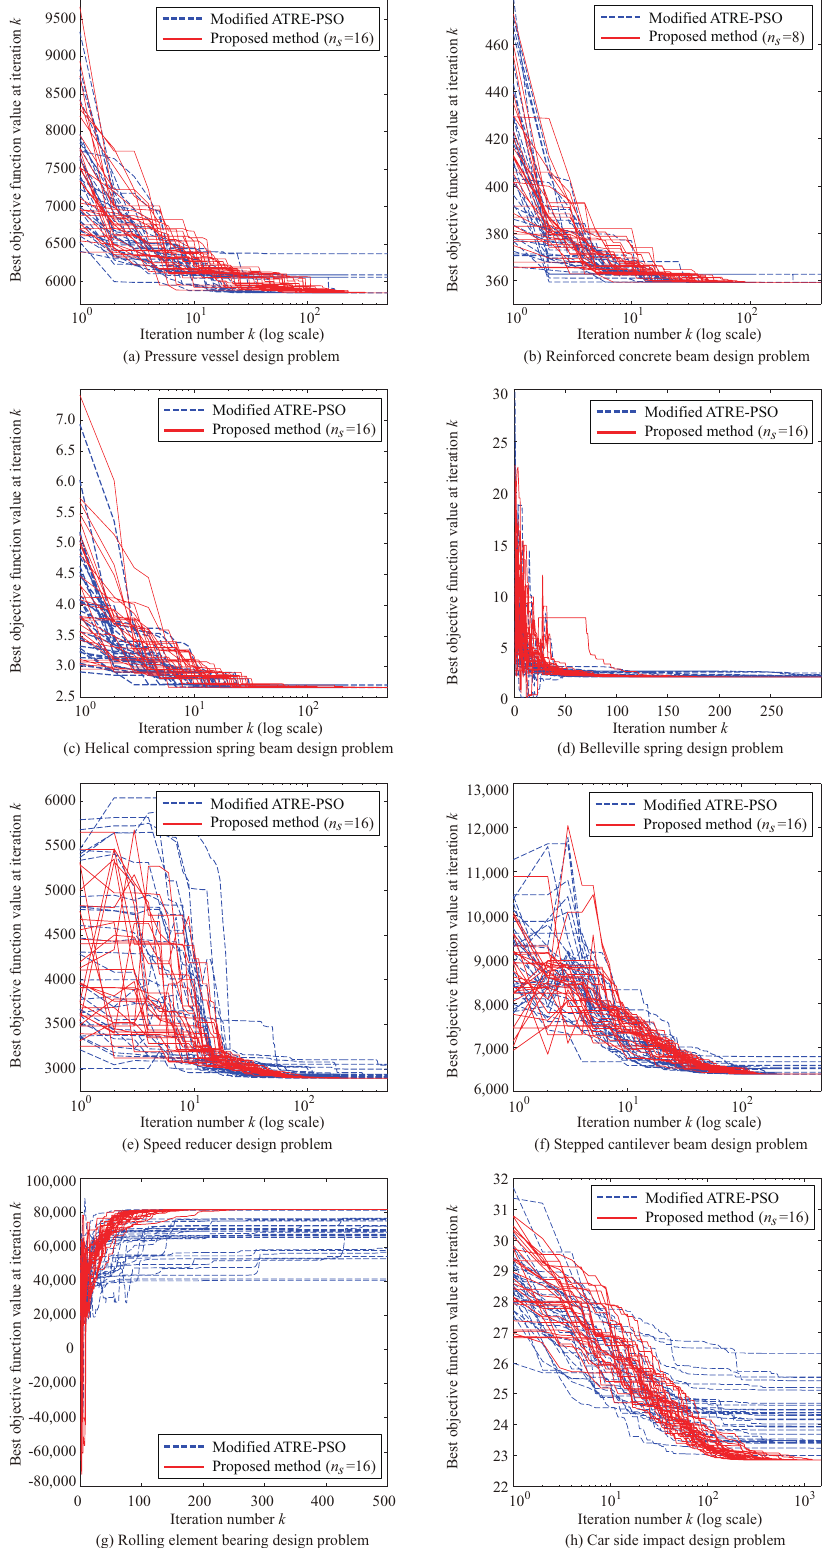
Figure 12. Convergence behaviors of f ( x ∗ ) for eight numerical